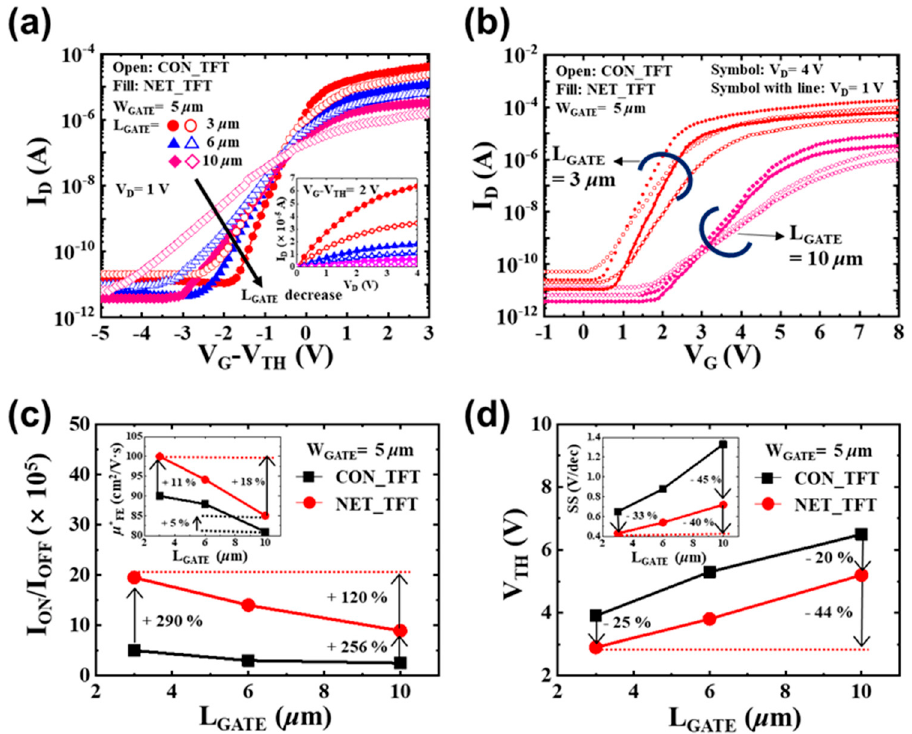
Figure 5. Comparison of the DC characteristics for NET_TFTs and CON_TFTs with different L GATE : ( a ) representative transfer curves (I D vs. V G -V TH ), ( b ) representative transfer curves with V D = 1 and 4 V, ( c ) an average ON/OFF current ratio, and ( d ) an average V TH . Insets show the measured output curves (I D vs. V D ), µ * FE , and SS as a function of L GATE .